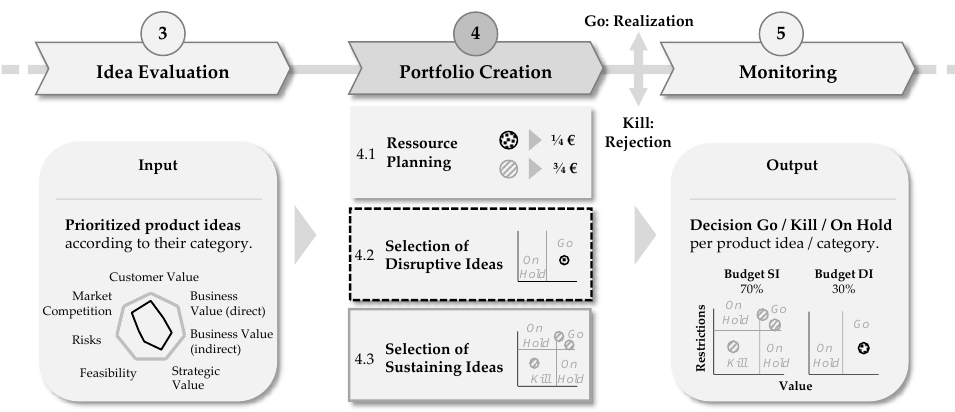
Figure 5. Portfolio Creation: Input/output and procedure.